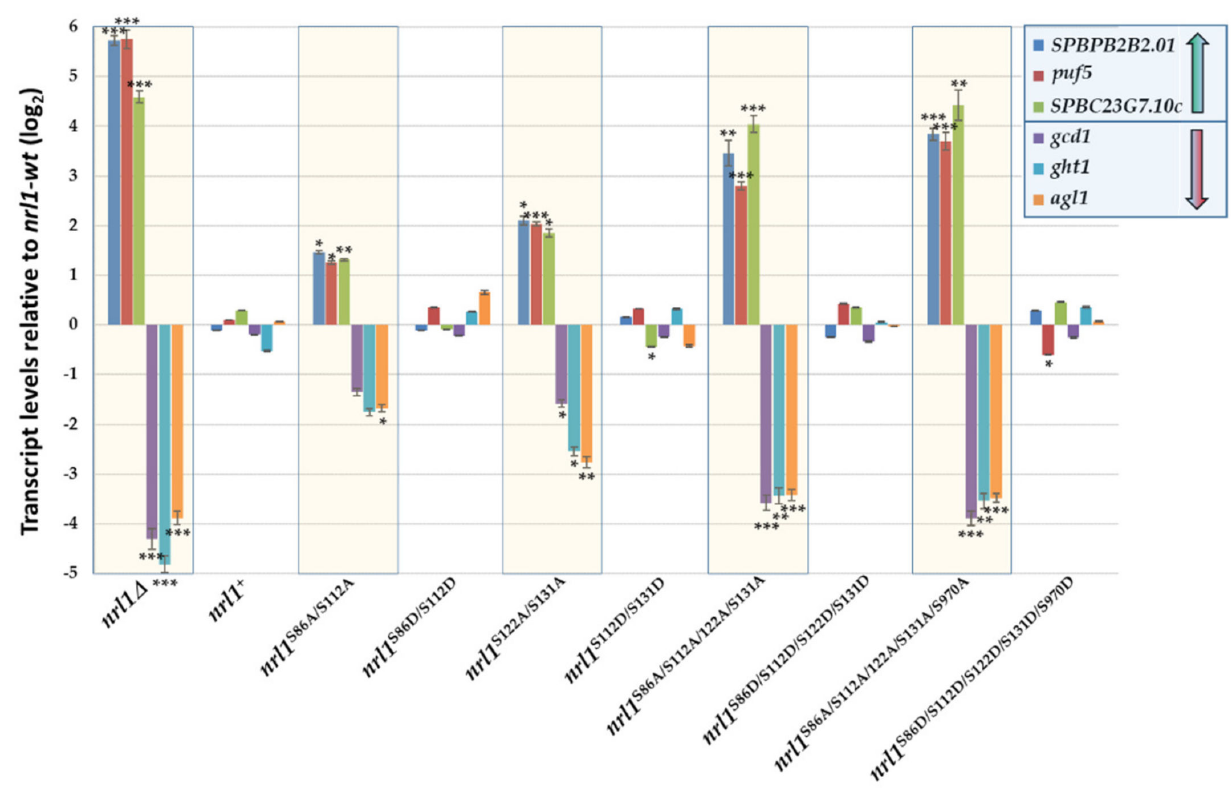
Figure 7. Analysis of gene expression in nrl1 ∆ and phosphorylation-site mutants nrl1 S/A and nrl1 S/D . RNA was isolated from cells in the exponential phase (OD 600 = 0.5–0.6), and gene expression of SPBPB2B2.01 , puf5 , SPBC23G7.10c , gcd1 , ght1 , and agl1 was analyzed using qPCR. The data represent mean values ± S.D. of transcript levels relative to wild-type nrl1 + after normalization to act1 from four independent biological replicates. Statistical significance in expression of studied genes in nrl1 mutants compared to wild-type nrl1 + was determined using one-way analysis of variance using ANOVA ( p -values: *— p ≤ 0.05, **— p ≤ 0.01, ***— p ≤